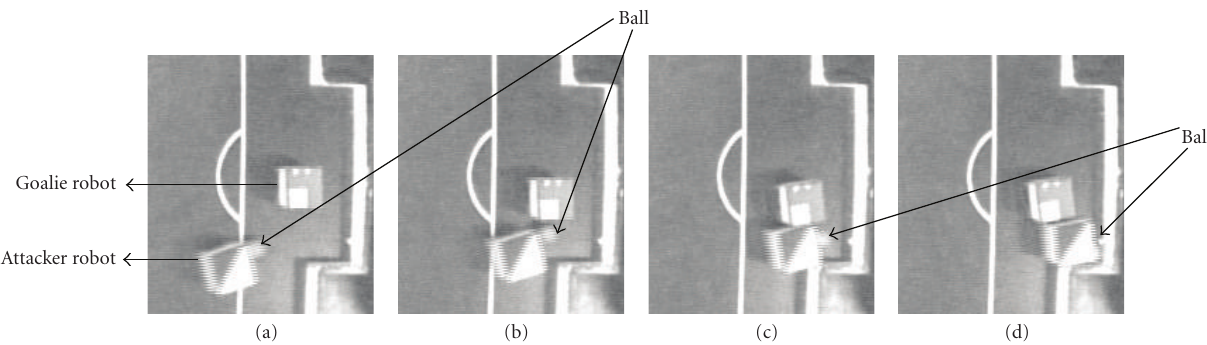
Figure 11: Four real time frames to decide goal shot behavior. (a) The attacker moves to the goal area to shoot the ball. (b) The goalkeeper tries to defend. (c) The goalkeeper is late and the attacker reaches the goal area. (d) A “goal shot” is made without any foul.